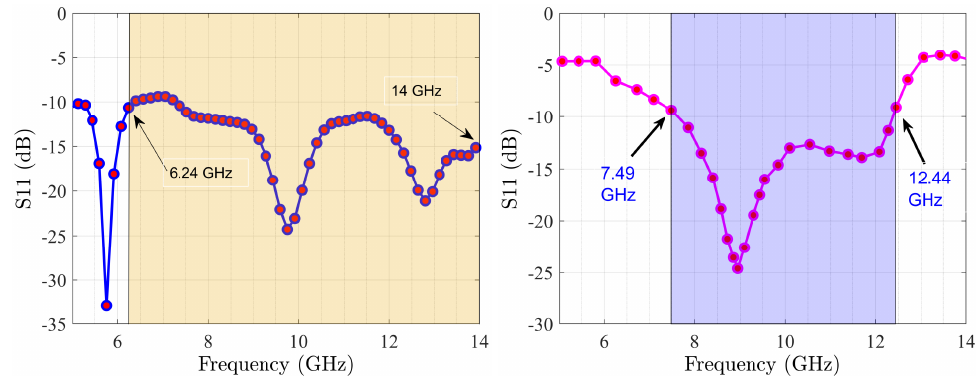
Figure 7. S 11 of optimized MIMO ( left ) with S 11 of optimized MMIC design ( right ) through